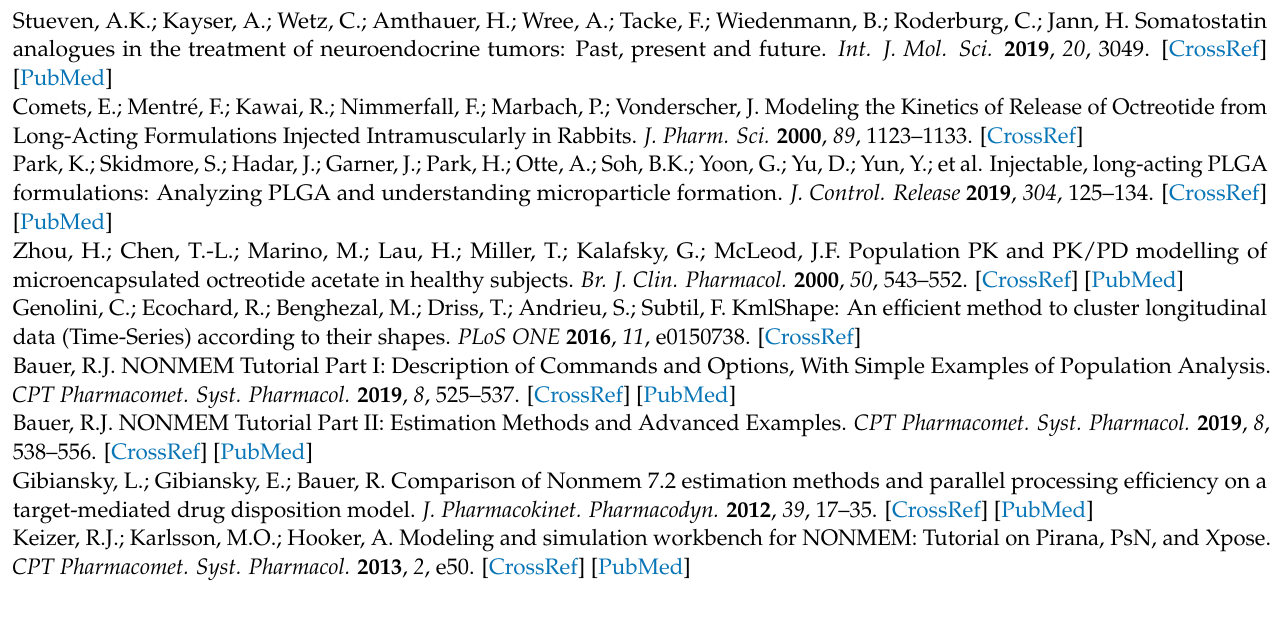
and the logarithmic scale. Figure S2: Goodness-of-fit plots for the evaluation of the final PPK model. Table S1: Parameter estimates of the base model and the corresponding inter-individual